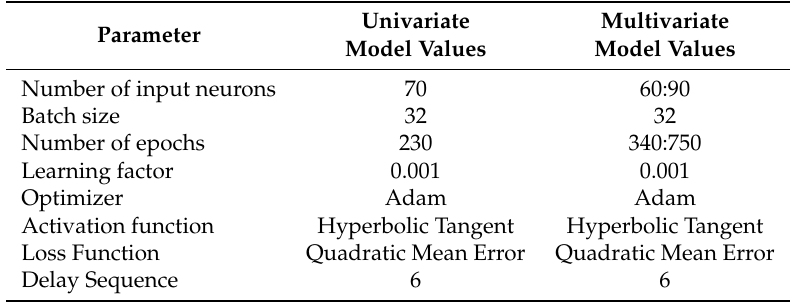
Table 2. Optimal parameter for LSTM execution experiments for the univariate and multivariate models.